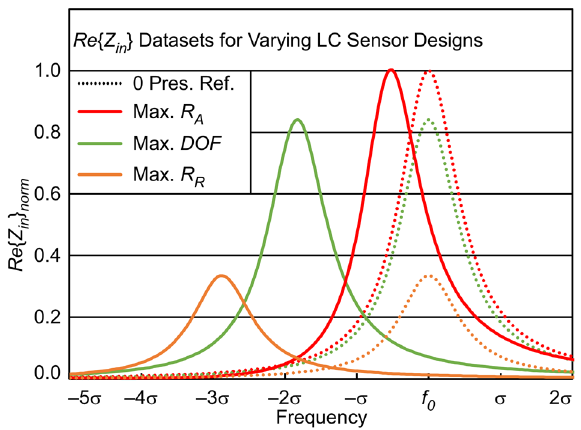
Figure 3. Comparison of example Re { Z in } datasets at 0 and 20 bar applied pressure for three LC sensor designs (given in Table 3). All datasets plotted over their bandwidth (i.e., bandwidth normalized). Table 3. Design Parameters used for Figure 3 Simulations.